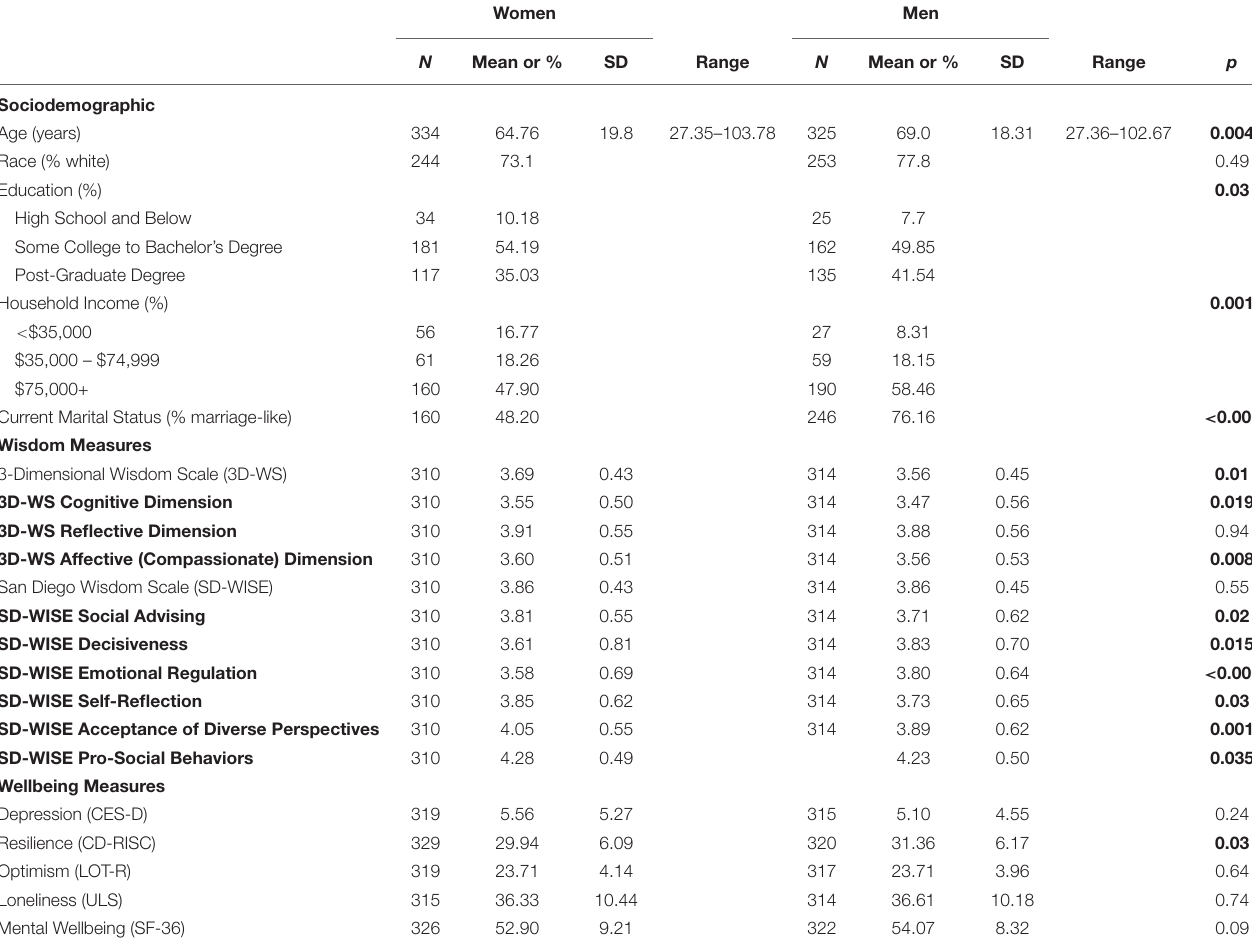
TABLE 1 | Demographic and clinical characteristics of women and men.